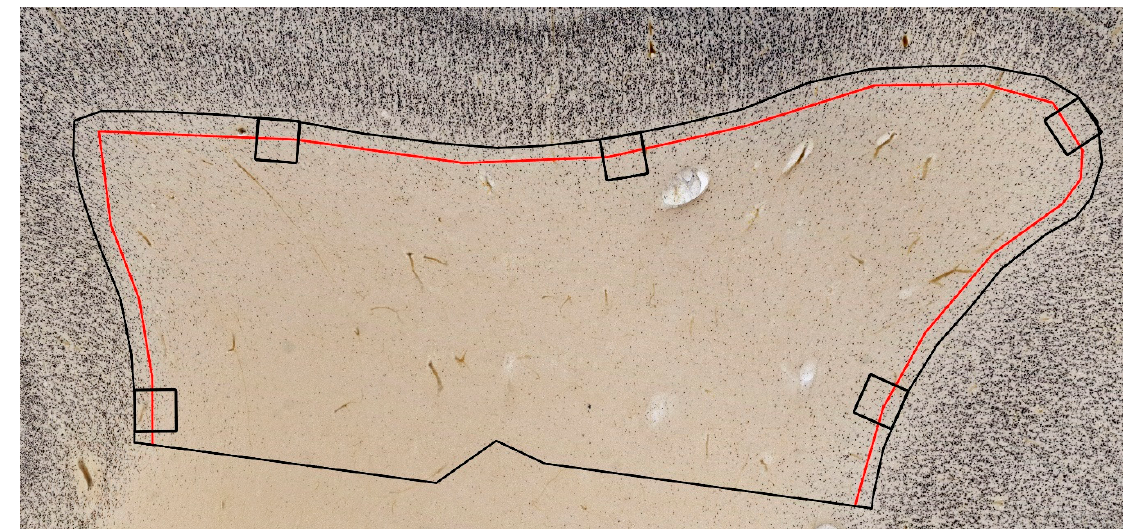
Figure 3. Illustration of different regions of interest for WMIN counting. Note the significant differences in surveying WMIN using pre-defined squares (black squares), an arbitrary region under the cortex (here 175 µm, red line), and the prospective von Monakow segment IV (defined here as 3 mm below cortex, black line). Note that the first two approaches leave out many of the WMIN, especially in the deeper parts of the white matter. The image is part of Zagreb Neuroembryological Collection [49].